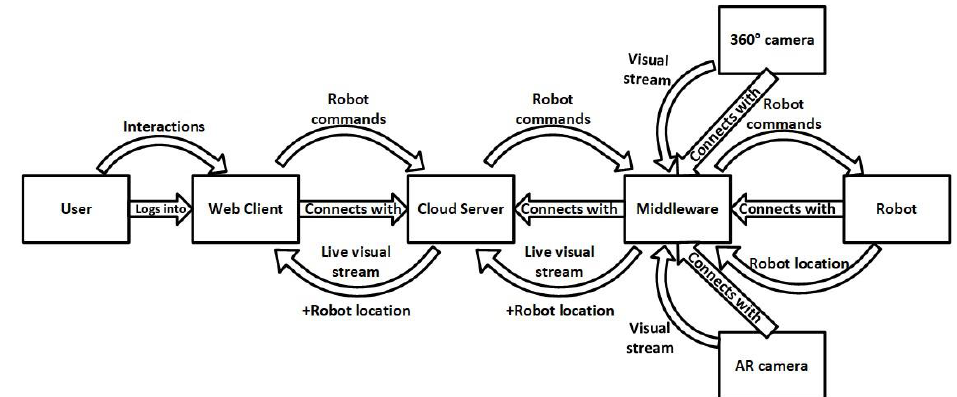
Figure 3. Network setup in the study.